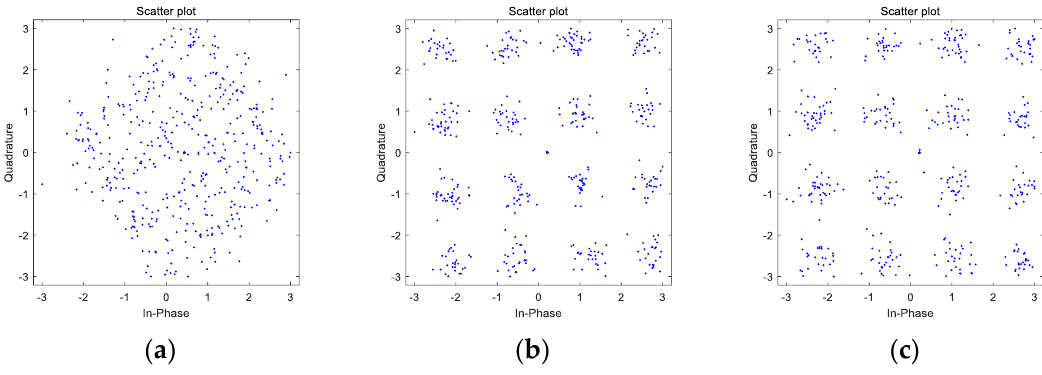
Figure 7. The constellations of the 16QAM signals in the polluted regions: ( a ) distorted weak 16QAM; ( b ) weak 16QAM after mitigation without delay; and ( c ) weak 16QAM after mitigation at the best delay.